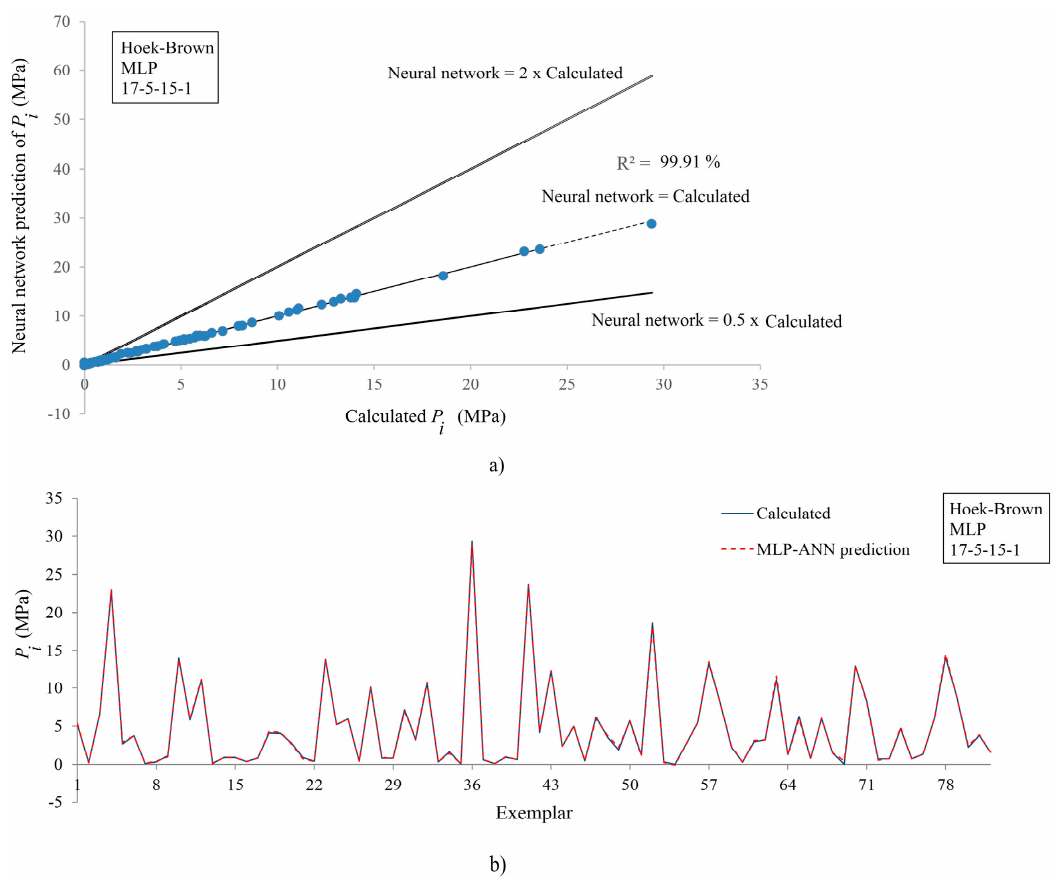
Figure 6. ( a ) Neural predicted P i versus calculated P i ; ( b ) differences between neural predicted P i and calculated P i for the best MLP-ANN (17-5-15-1) applied to the testing data series for the Hoek–Brown criterion.